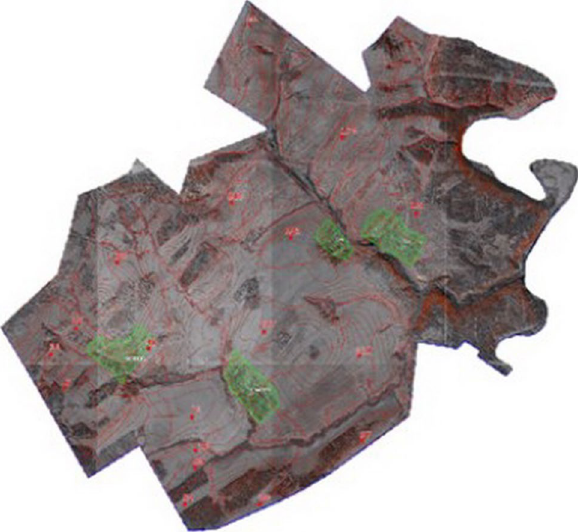
Figure 5. Orthophotoplan within the boundaries of the Salavatskiy district of the Republic of Bashkortostan, 2007.